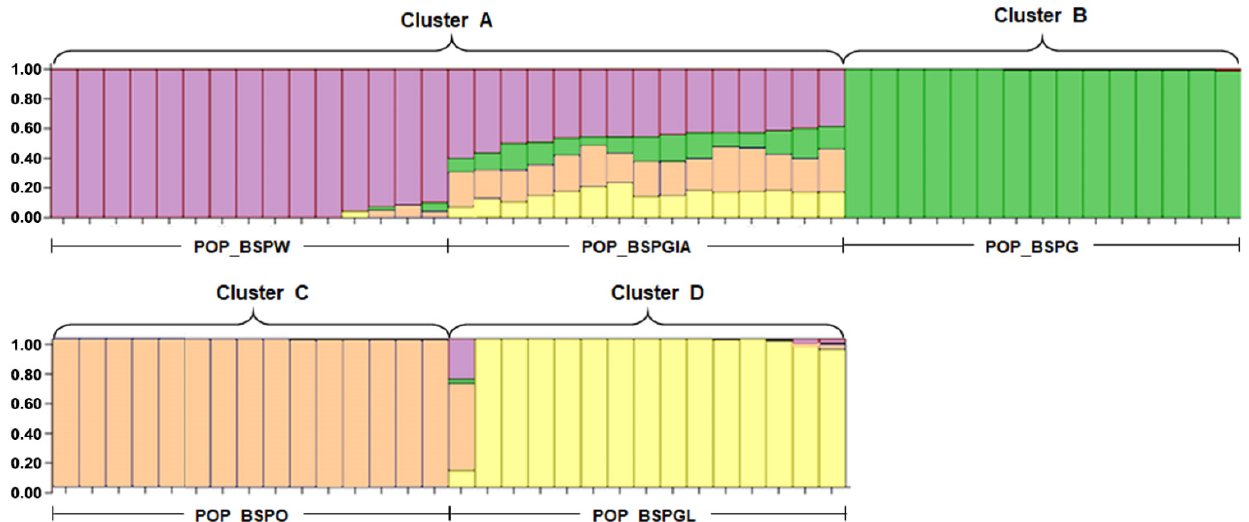
Figure 1. Population structure of 75 samples (40 males and 35 females) of Siamese fighting fish ( Betta splendens Regan, 1910) [1]. Plot of Evanno’s ∆ K . Structure bar plots depicting the results of model-based clustering inferred for K = 4. Inferred genetic clusters are indicated by different colors. Each vertical bar on the x-axis represents an individual, and the y-axis represents the proportion of membership (posterior probability) in each genetic cluster. Commercial Siamese fighting fish clusters derived from five populations, including cluster A (POP_BSPGIA and POP_BSPW), cluster B (POP_BSPG), cluster C (POP_BSPO), and cluster D (POP_BSPGL).